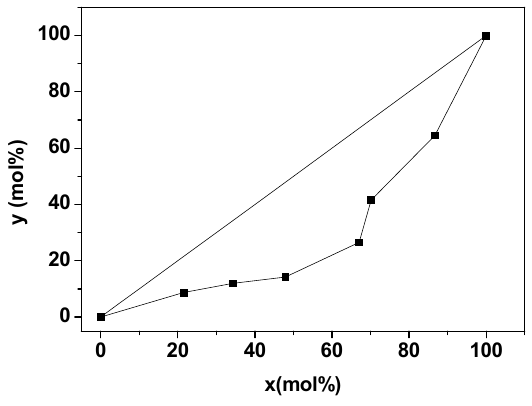
Figure 2. Pseudo-x-y diagram of C 2 H 4 /CH 4 binary systems. Temperature, initial pressure, and water cut are 274.15K, 3.4 MPa, and 30 vol%,